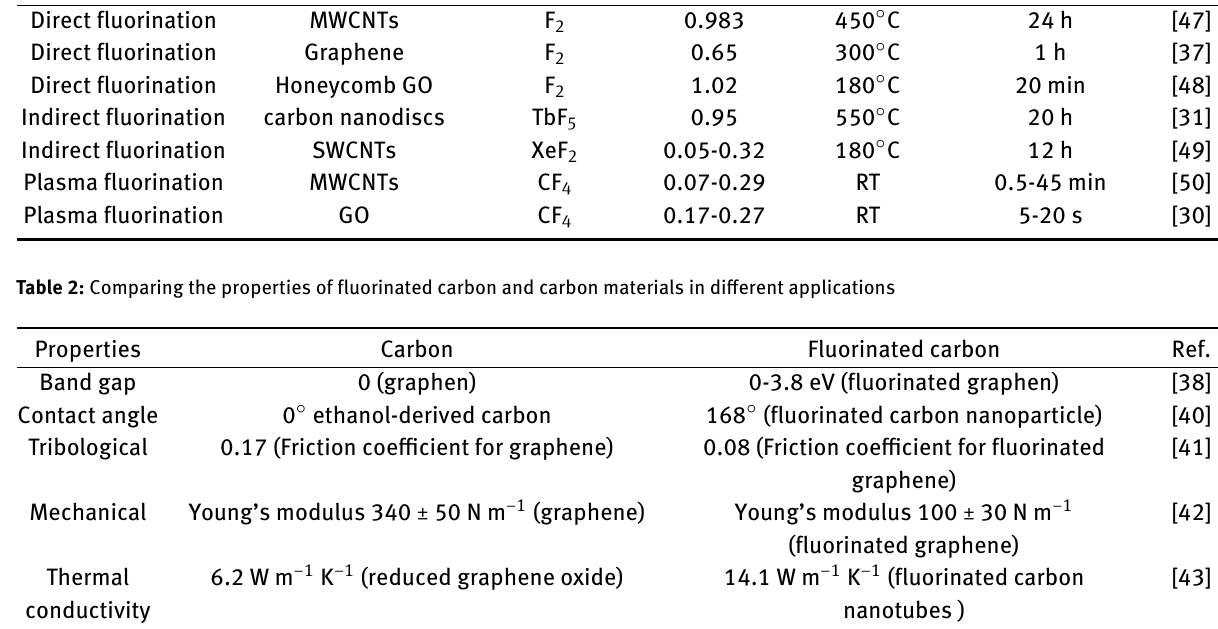
Table 1: Preparation methods and conditions for fluorinated carbon Preparation method